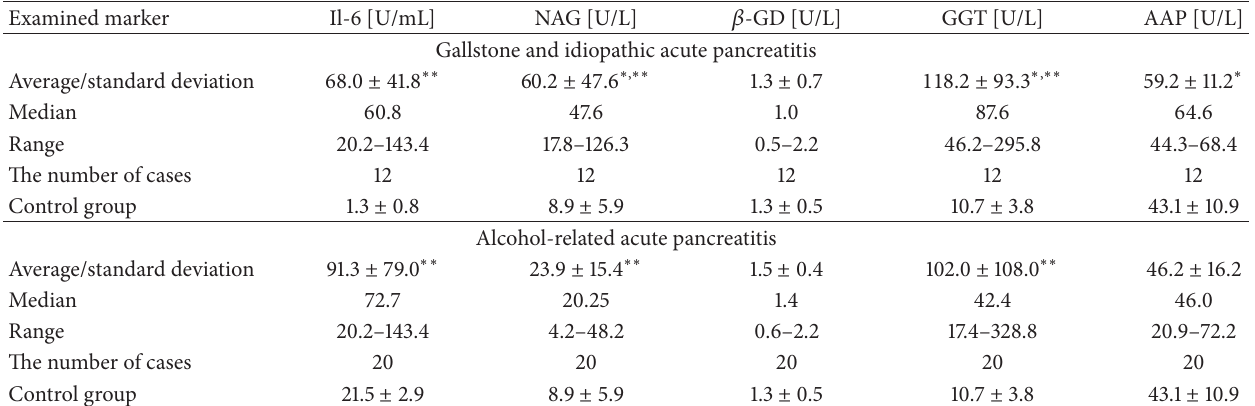
Table 4: Biochemical parameters in patients with acute pancreatitis related to gallstone and alcohol abuse (in the first 24 hours after admission).